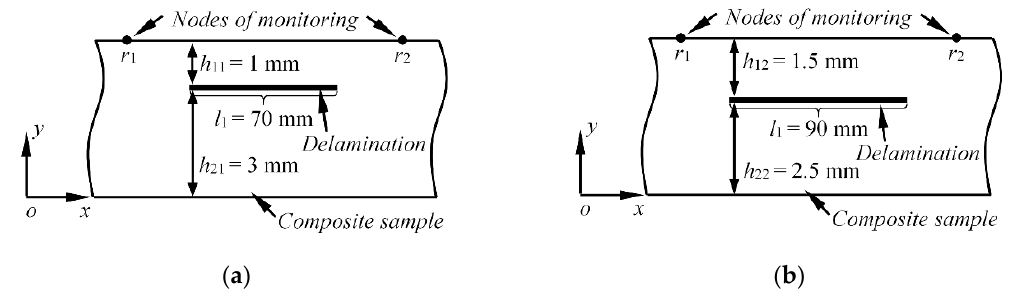
Figure 12. Graphic representation of investigated cases: sample No. 1 with 70 mm wide delamination located 1 mm below the surface ( a ), sample No. 2 with delamination of 90 mm at depth of 1.5 mm ( b